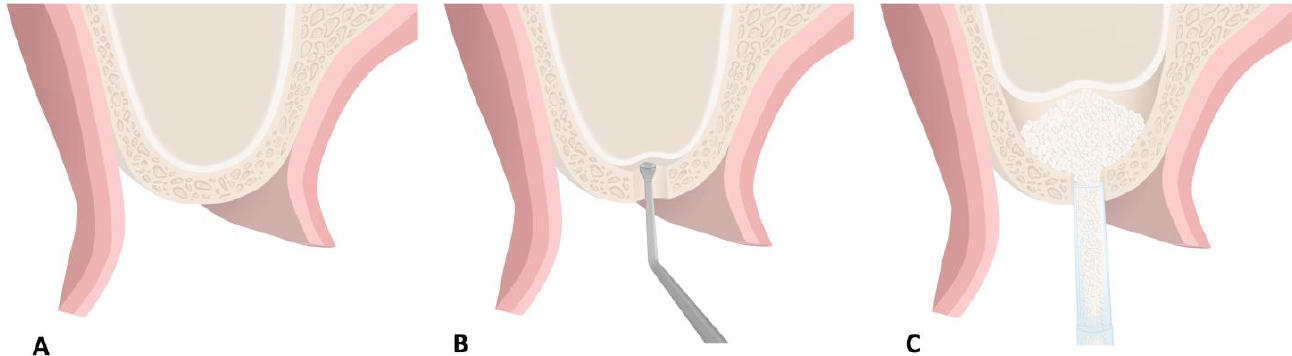
Figure 3. Transalveolar Approach for Maxillary Sinus Augmentation. ( A ) A full thickness mucoperiosteal flap is raised on the edentulous ridge. ( B ) After marking the location of the future implant, the site is prepared with implant drills to approximately 1.0–1.5 mm below the sinus floor. Osteotomes are used to fracture the sinus floor and elevate the membrane. ( C ) The sinus compartment is gradually filled with grafting material until the appropriate depth for implant placement is achieved. Reprinted from [99] with permission from Elsevier.